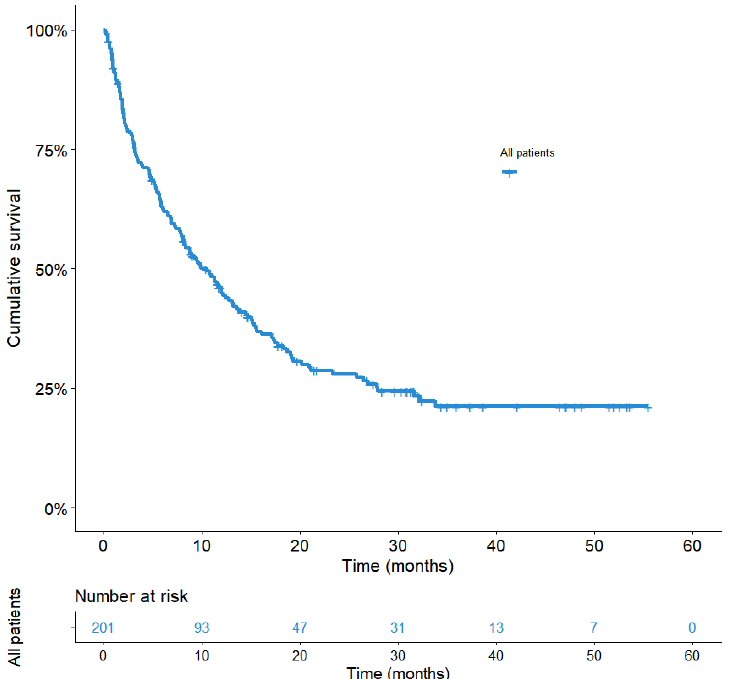
Figure 2. Overall survival in the entire population. Overall survival curve from day 1 of ICI, according to the Kaplan – Meier method is shown for the 201 accrued patients. Median OS for the whole series was 10.4 months (95%CI: 7.7 – 13.1).